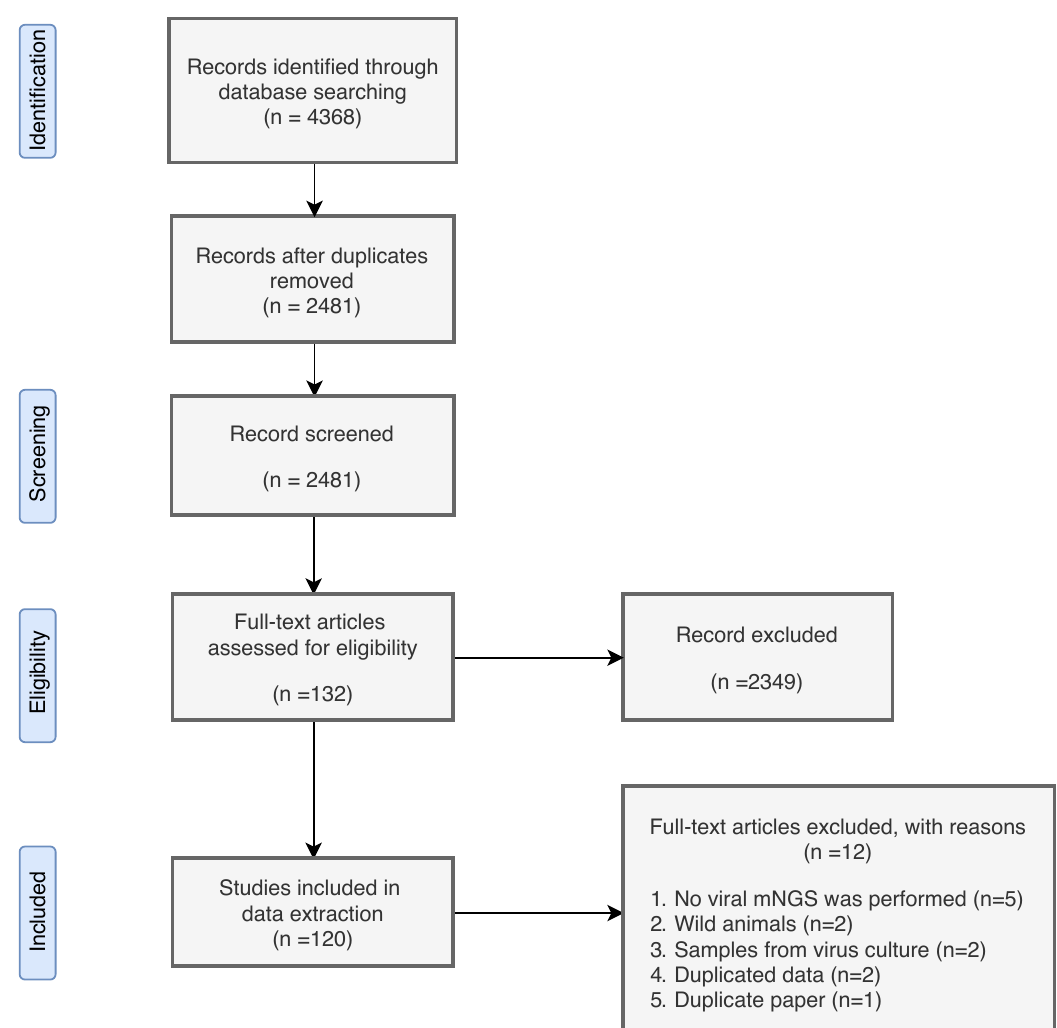
Figure 1. Flow chart of systematic review. The procedures were adapted from the Preferred Reporting Items for Systematic Reviews and Meta-Analyses (PRISMA)